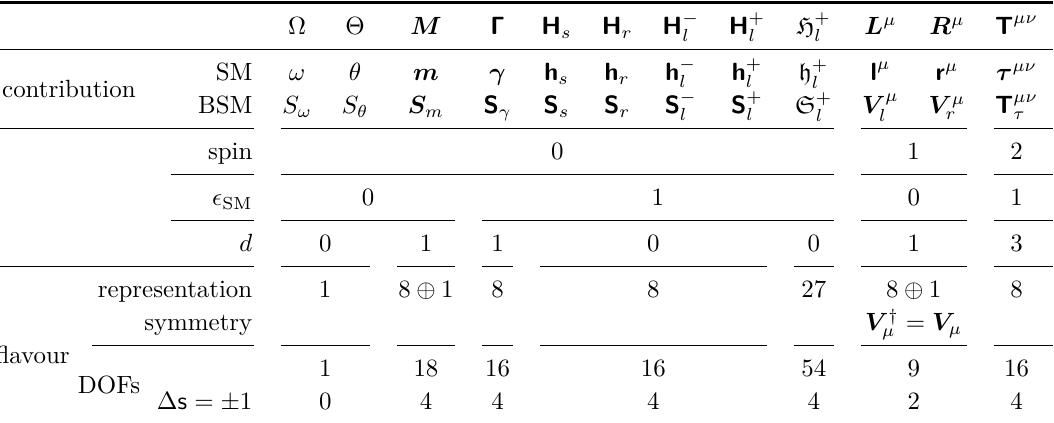
at which they SM